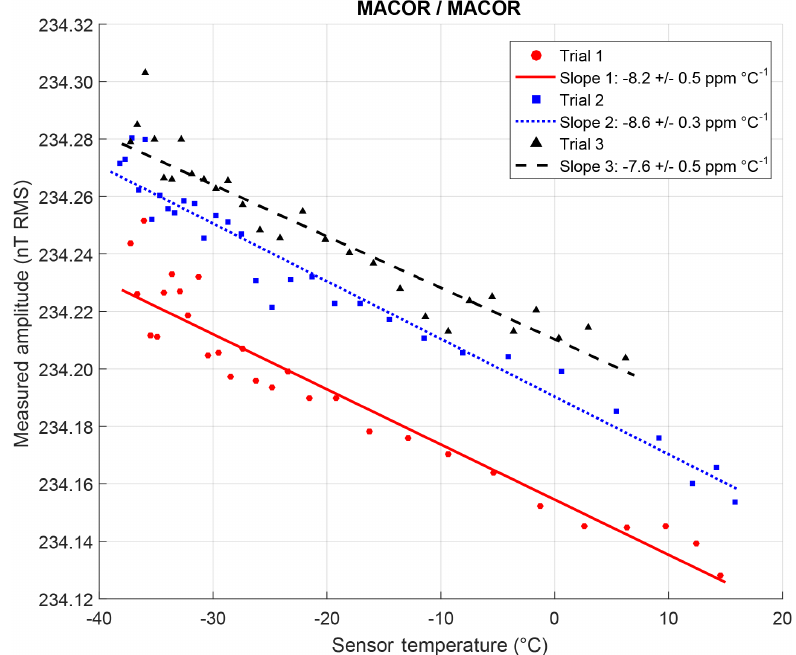
Figure 13. Results the MACOR/MACOR sensor trials 1 (red; solid; circle), 2 (blue; dotted; square), and 3 (black; dashed; triangle) for showing the measured amplitude of the test signal (scatter plot) and the linear trend (solid, dotted, and dashed lines) determined by robust linear regression. The slope of each trial estimates the coefficient of thermal gain dependence for the